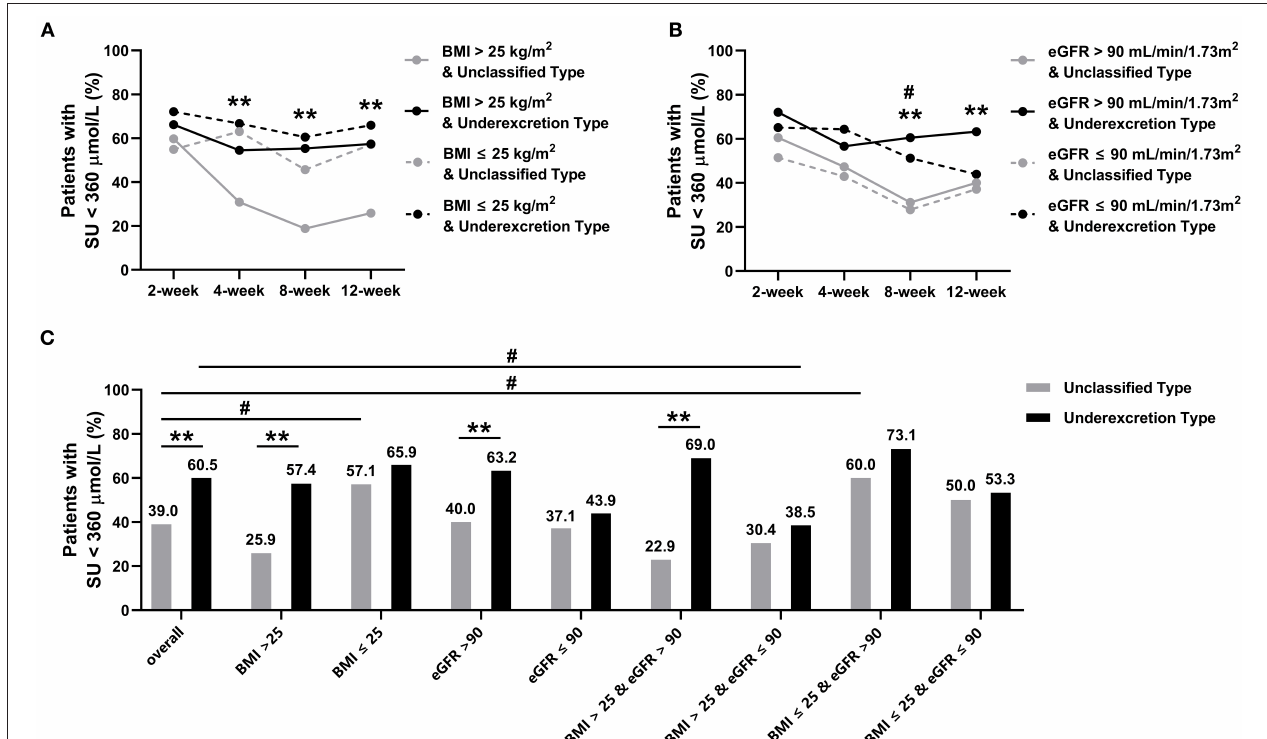
FIGURE 3 | Proportion of patients with serum urate (SU) < 360 µ mol/L in subgroups during the 12-week study. (A) Subgrouped by BMI ( > 25 kg/m 2 or ≤ 25 kg/m 2 ), symbols * and ** indicate P < 0.05 and < 0.01 in BMI > 25 kg/m 2 between unclassified and underexcretion groups, respectively. (B) Subgrouped by eGFR ( > 90 mL/min/1.73 m 2 or ≤ 90 mL/min/1.73 m 2 ), symbols * and ** indicate P < 0.05 and < 0.01 in eGFR > 90 ml/min/1.73 m 2 between unclassified and underexcretion groups, respectively; symbols # and ## indicate P < 0.05 and < 0.01 between eGFR ≤ 90 ml/min/1.73 m 2 in unclassified and underexcretion groups, respectively. (C) Subgrouped by BMI and eGFR (BMI > 25 kg/m 2 and eGFR > 90 mL/min/1.73 m 2 , BMI > 25 kg/m 2 and eGFR ≤ 90 mL/min/1.73 m 2 , BMI ≤ 25 kg/m 2 and eGFR > 90 mL/min/1.73 m 2 , BMI ≤ 25 kg/m 2 and eGFR ≤ 90 mL/min/1.73 m 2 ), symbols * and ** indicate P < 0.05 and < 0.01 between unclassified